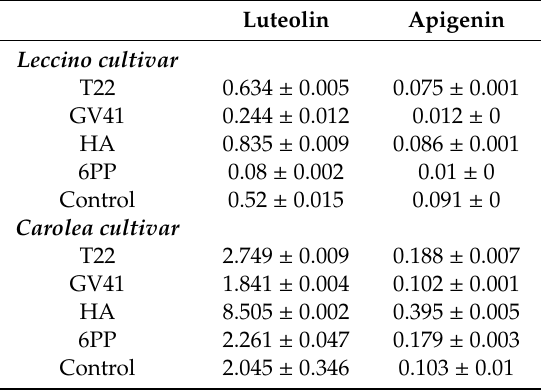
Table 6. Content of flavonoids in EVOO (mg / kg).